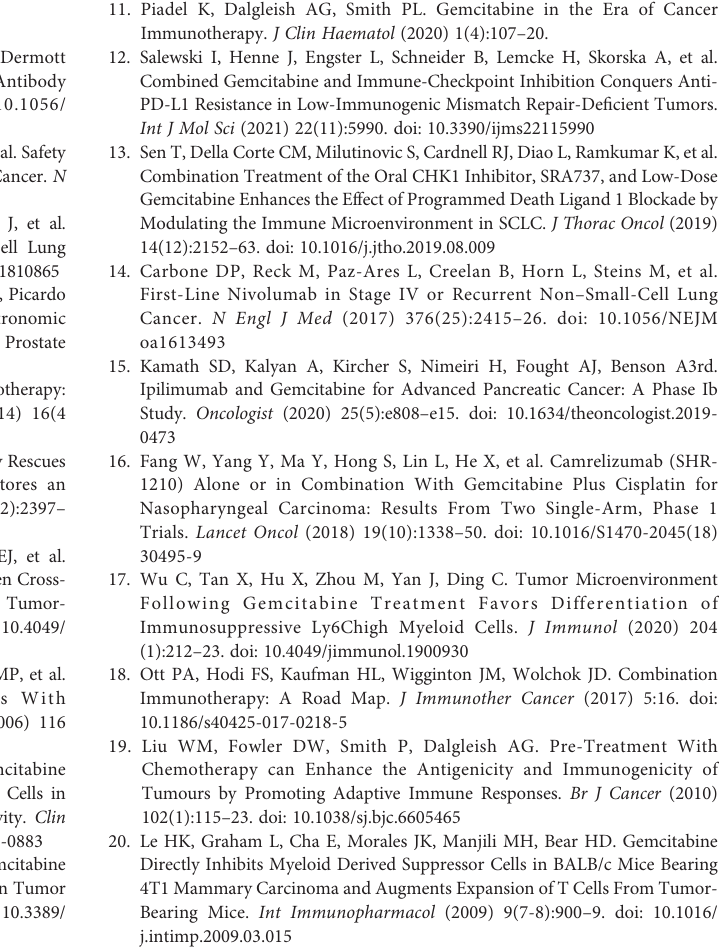
Supplementary Figure 1 | Kaplan – Meier estimates of III and IV disease stage patients. (A) Kaplan – Meier estimates of progression-free survival; (B) Kaplan – Meier estimates of overall survival. Supplementary Figure 2 | >Immune parameters in PR, SD and PD group. The baseline peripheral blood absolute T lymphocyte count (A) , absolute CD3 + CD4 + lymphocyte count (B) , absolute CD3 + CD8 + lymphocyte count (C) , percentage of regulatory T cells (D) , absolute B lymphocyte count (E) , percentage of B lymphocytes (F) , absolute NK cell count (G) , and percentage of NK cells (H) were compared in each two groups. The data calculated as the means ± standard deviation using IBM SPSS statistics 21, no signi fi cant difference in any pre-treatment immune parameters were observed between groups (P > 0.05). Supplementary Figure 3 | Lymphocyte levels before and after low-dose gemcitabinecombinedwithPD-1inhibitortreatment.Shownarethetotalnumberof T (A) , B (B) and NK (C) cells in peripheral blood at the baseline, after 1st cycle treatment and 2nd cycle